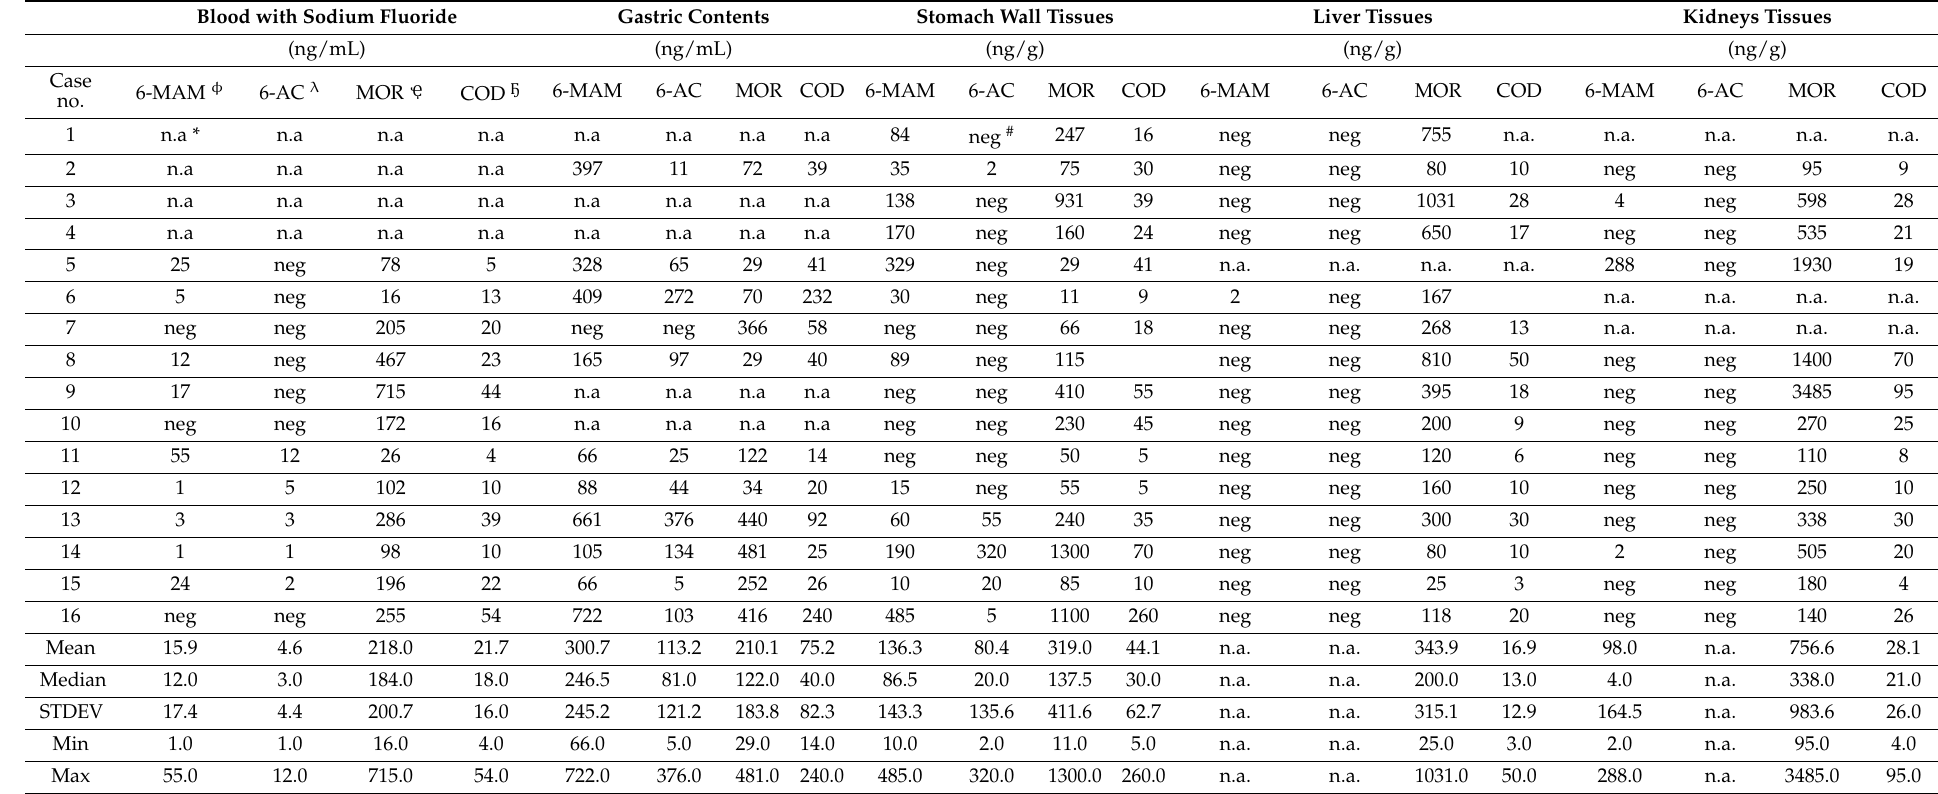
Table 4 . Analyte concentrations in 16 heroin-related deaths analyzed in this study . Blood with Sodium Fluoride